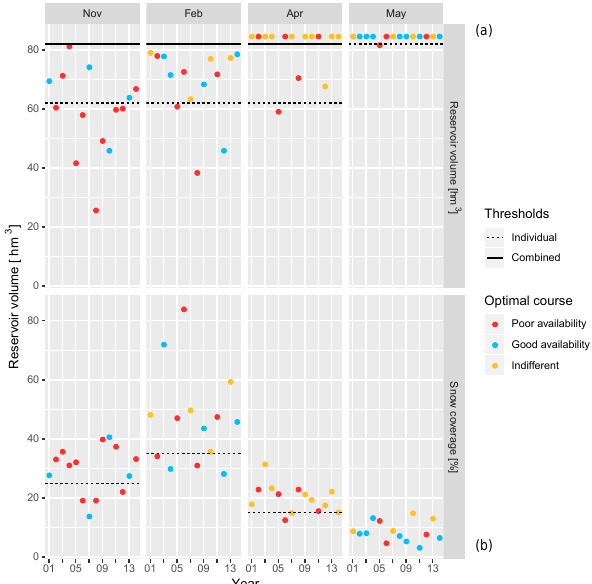
Figure 5. The position of the points represents reservoir levels (a) and snow cover (b) for the period 2001–2014. The points are coloured according to the decisions made with perfect information at those decision points, which are considered to be the “optimal course”, and refer to the paths illustrated in Fig. 3. The individ- ual thresholds mark the threshold for reservoir level or snow cover when considered independently, while the combined thresholds are the modified thresholds for reservoir level for years in which the snow cover threshold is not